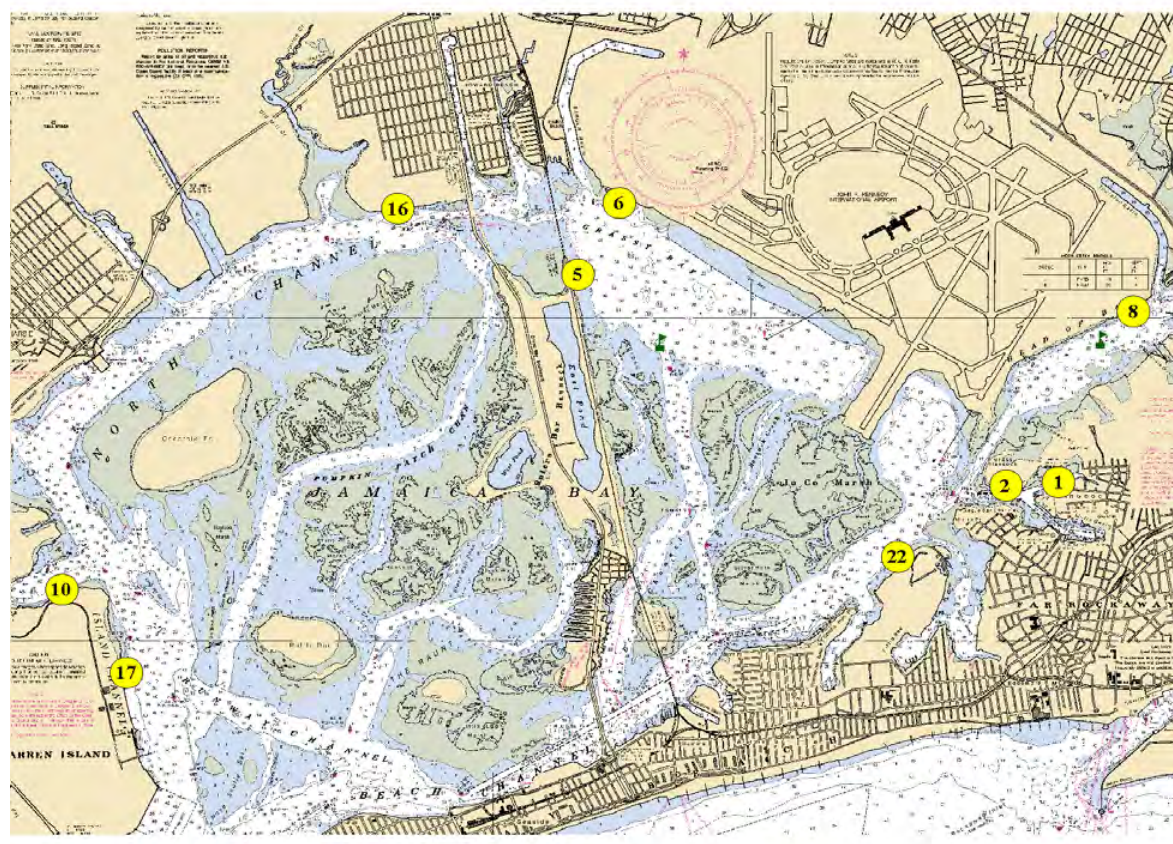
Figure 34. Map of New York DEC Western Long Island Beach Seine Survey Jamaica Bay